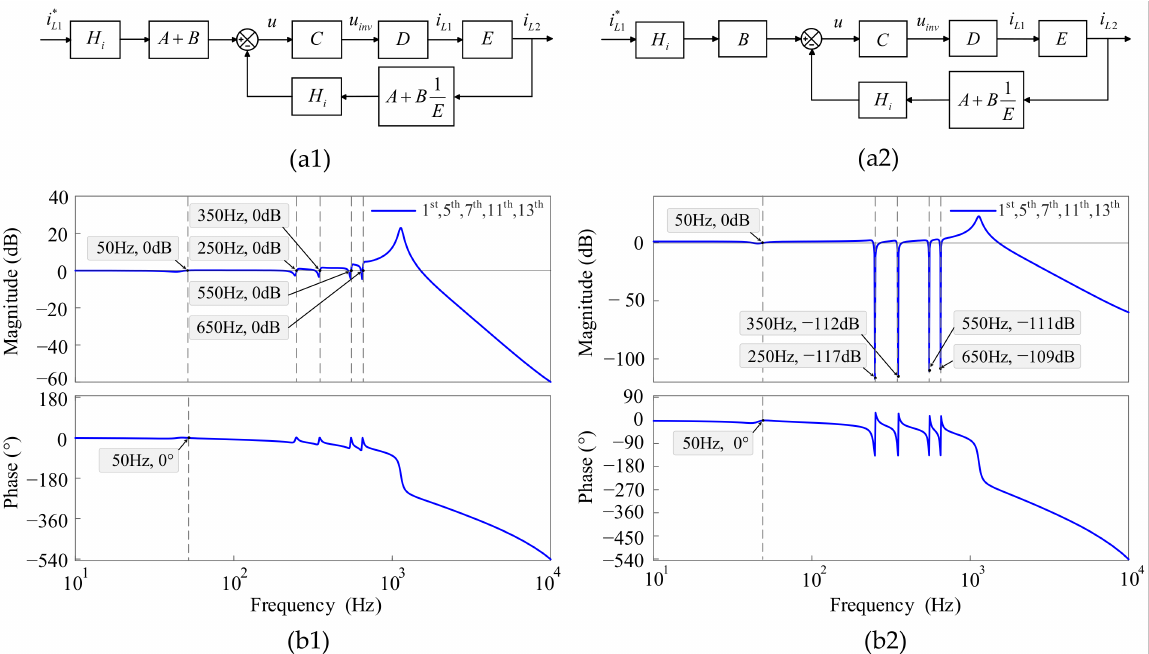
Figure 3. Control block diagrams and the corresponding closed-loop Bode plots: ( a1 , b1 ) The original ones; ( a2 , b2 ) the improved